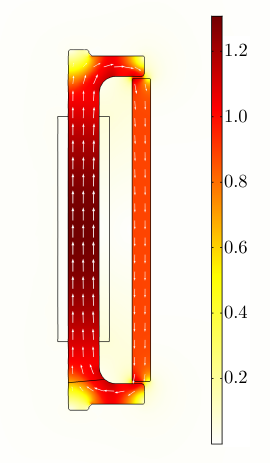
Figure 5. FEM solution of the magnetic flux density at 18 A, for the